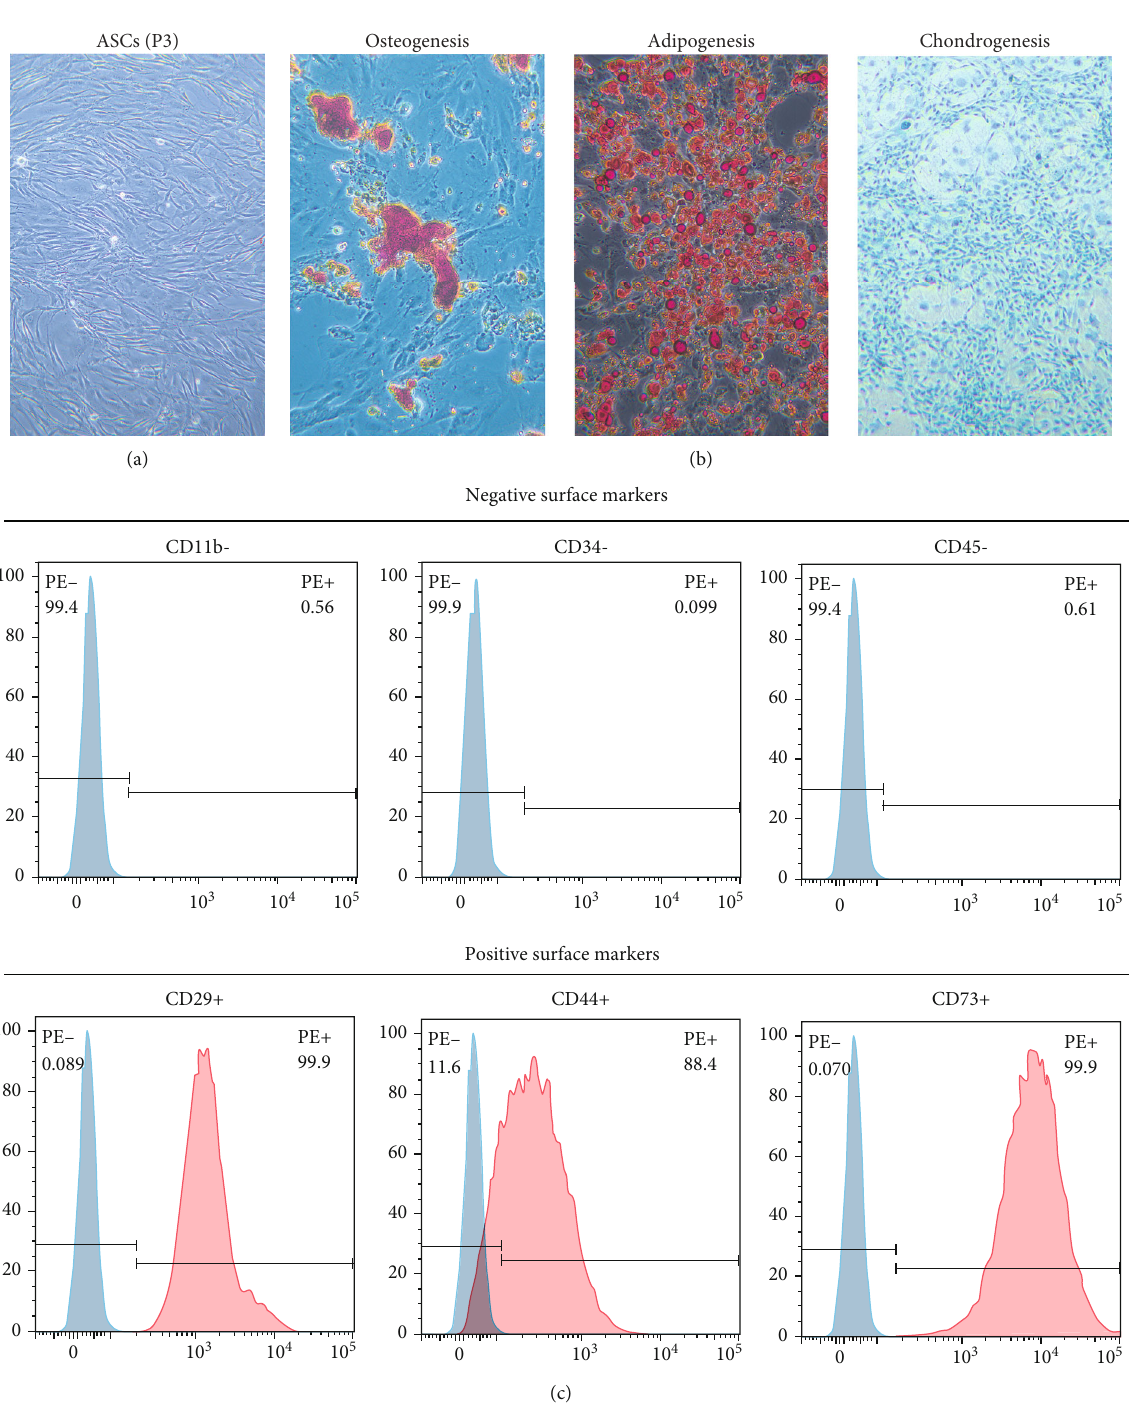
Figure 2: Isolation and identi fi cation of ADSCs. (a) The morphology of the isolated ADSCs from rat at passage 2. Bar = 100 μ m. (b) Osteogenic di ff erentiation, chondrogenic di ff erentiation, and adipogenic di ff erentiation of ADSCs revealed by Alizarin Red, Alcian blue, and Oil red O staining. Bar = 100 μ m. (c) The expression of cell surface markers related to stem cell phenotype in ADSCs using fl ow cytometry analysis, which were positive for CD29, CD44, and CD73 and negative for CD11b, CD34, and